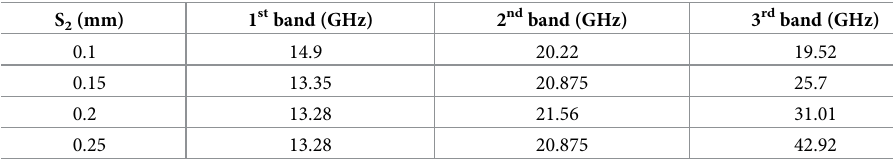
Table 6. Simulated result of quality factor for different values of S 2 .